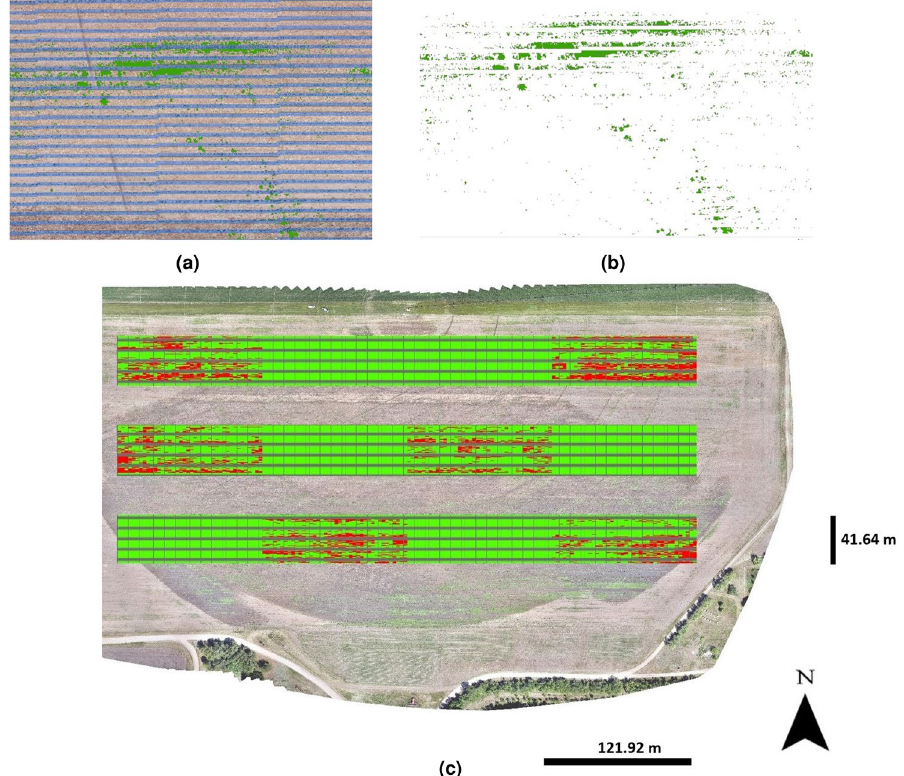
Figure 5. Buffered (3.5-inch on both sides) corn rows ( a ) that were removed from the imagery to create the weed map across the field ( b ) and the ( c ) variable rate prescription map (green cells = 140.3 L/ha and red